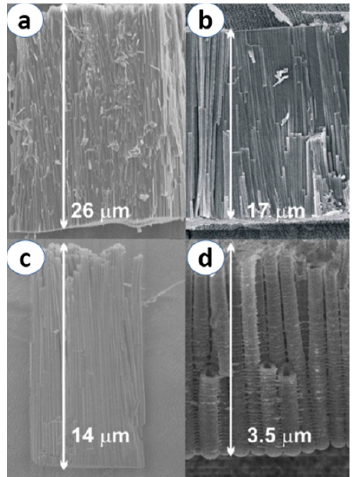
Figure 5. Cross-sectional images of TiO 2 nanotubes synthesized by applying 60 V for 6 h using different electrolyte ages: ( a ) fresh electrolyte, ( b ) 6 h, ( c ) 25 h and ( d ) 50 h. Reprinted with permission from Ref. [51] Copyright 2015 Elsevier.